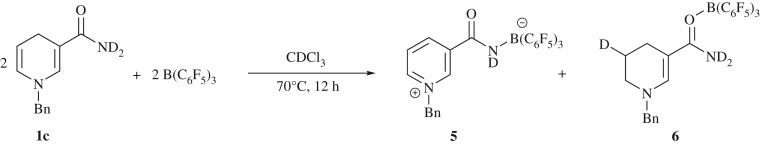
Deuterium labelling studies of 1c.